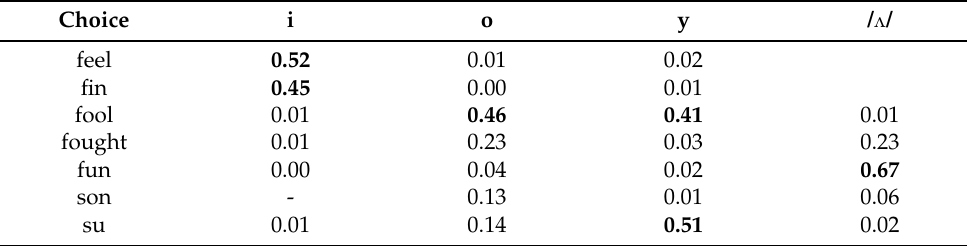
Table 13. The percentage of categorizations of German phonemes in the L1 English